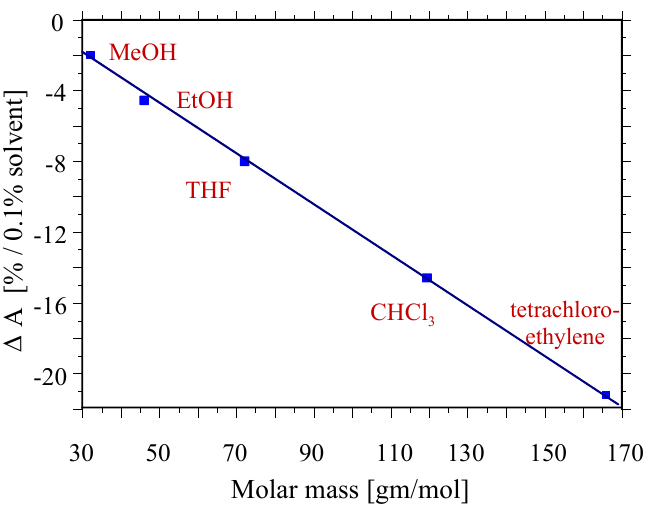
Figure 3. Optical sensor response of CLCs towards molar masses of different analyte vapours.